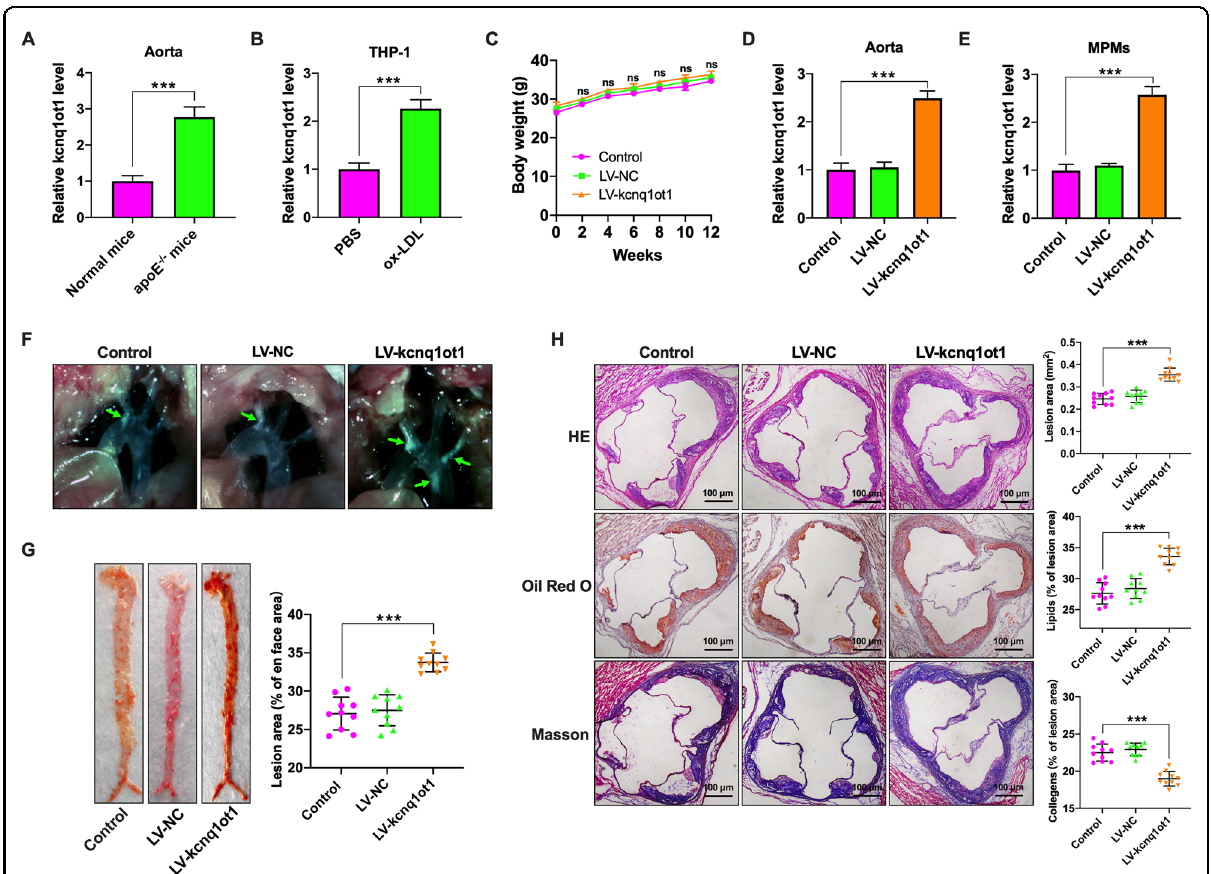
Fig. 1 Kcnq1ot1 aggravates atherosclerosis in apoE − / − mice. A C57BL/6 mice and apoE − / − mice were fed a normal chow diet and a Western diet for 12 weeks, respectively ( n = 10 per group). Kcnq1ot1 expression in the aorta was detected by qRT-PCR. B THP-1 macrophages were treated with PBS or 50 µg/mL ox-LDL for 48 h, followed by qRT-PCR analysis of kcnq1ot1 expression ( n = 3). C – H Western diet-fed apoE − / − mice were injected via the tail vein with PBS, LV-NC, or LV-kcnq1ot1 ( n = 20 in each group). C Comparison of weight. D , E The qRT-PCR analysis of kcnq1ot1 expression in the aorta and MPMs. F The plaques (green arrows) in the aortic arch of apoE − / − mice under a stereoscopic microscope. G The entire aorta was stained with Oil Red O and the atherosclerotic lesion area was quanti fi ed by analyzing Oil Red O-positive region on en face preparations ( n = 5 per group). H Sections of the aortic root were stained with HE, Oil Red O, or Masson. Lesion area and percentage was quanti fi ed using Image- Pro Plus 7.0 software ( n = 10 per group). Scale bar = 100 μ m. Data are represented as mean ± SD. *** P < 0.001; ns not signi fi cant vs. control